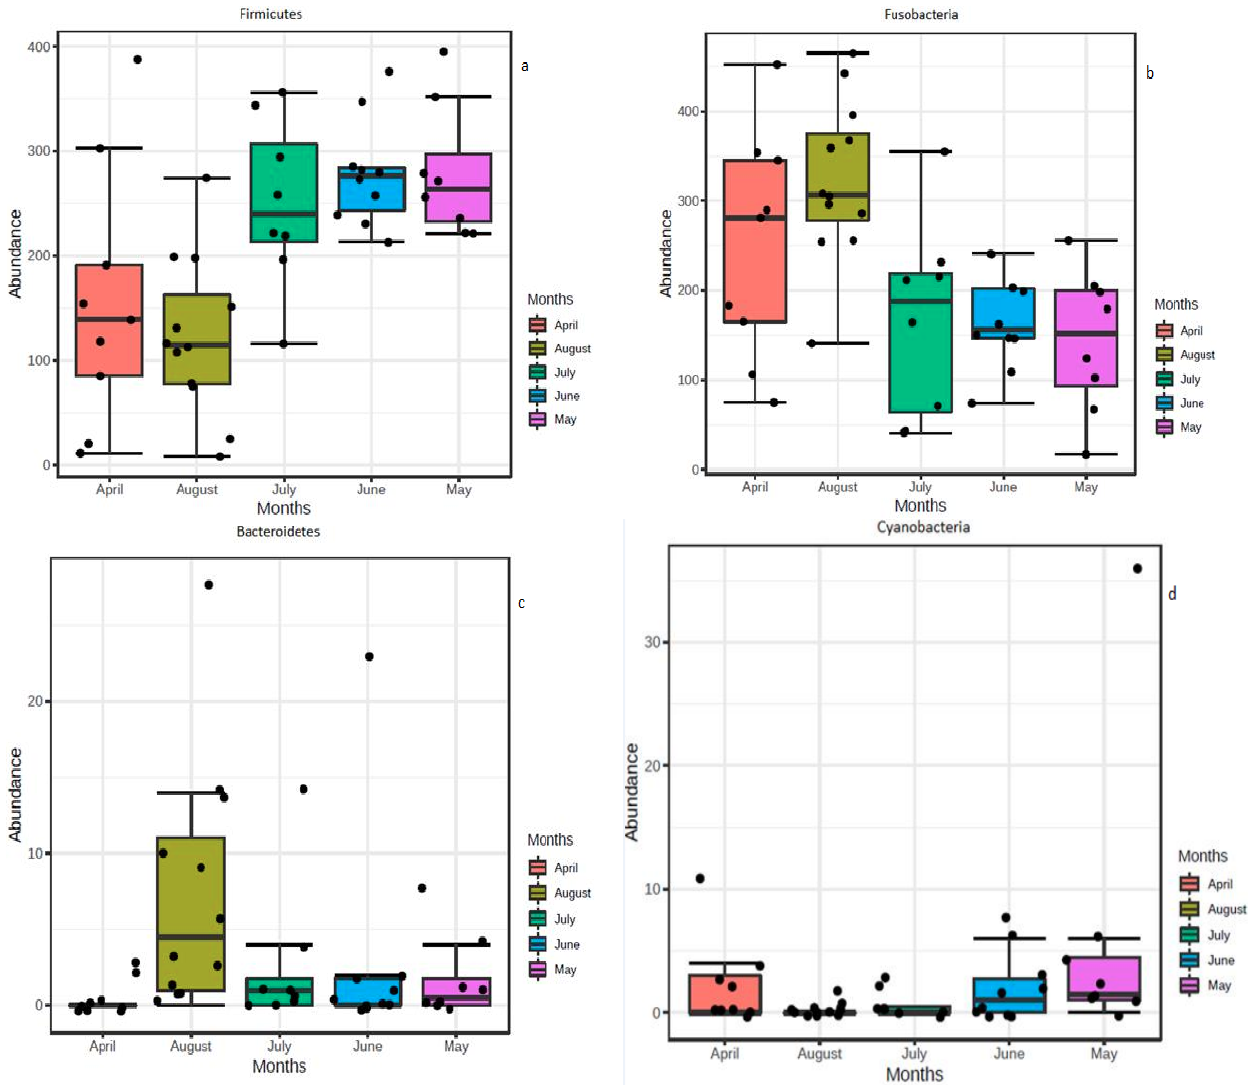
Figure 3. Comparative abundances of all the Lake Tana samples identified by univariate nonparametric analysis (Mann– Whitney test) based on a single grouping variable at phylum level. The black points represent individual samples. Features are considered to be significant based on their adjusted p-value = 0.05. All phyla showed significant p -value. ( a ) Phylum Firmicutes, ( b ) Phylum Fusobacteria, ( c ) Phylum Bacteroidetes and ( d ) Phylum